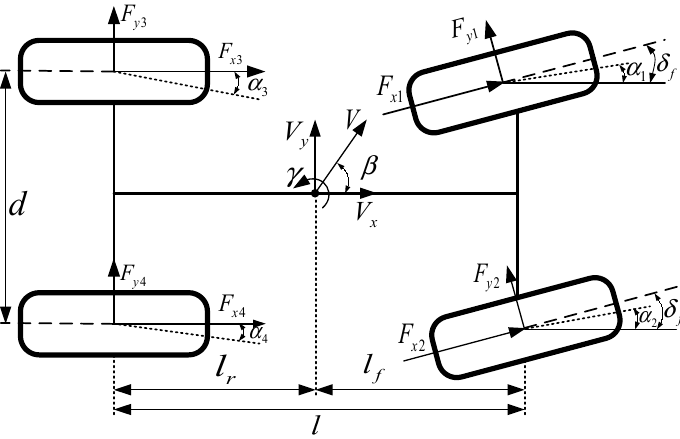
Figure 1. The seven degrees of freedom (DOF) vehicle mode. When the front wheel angle is δ f , longitudinal forces, lateral forces, and the yaw moment at the vehicle center of mass are as follows.